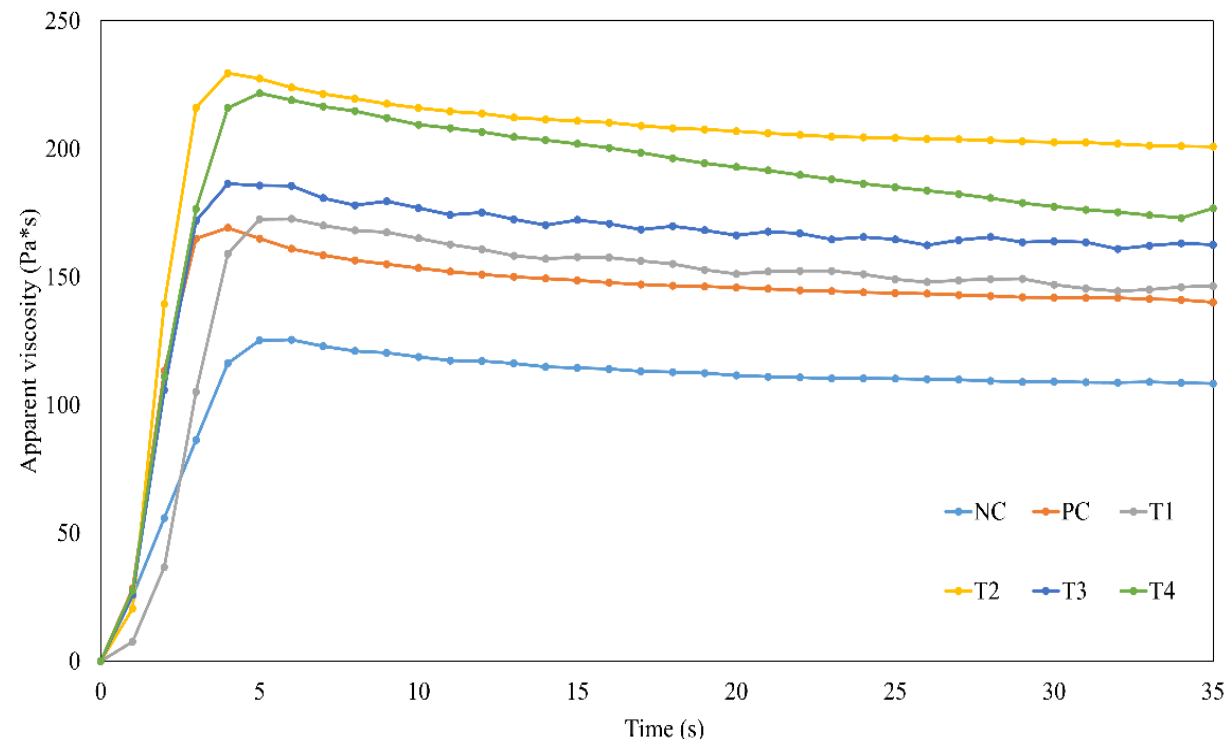
Figure 2. Effects of grafted insect protein and eggshell powder on the texture profile analysis of phosphate-free meat emulsion. NC: negative control not containing phosphate, PC: positive control containing 0.15% phosphate, T1: meat emulsion containing 0.10% GI, T2: meat emulsion containing 0.1% GI and 0.1% ES, T3: meat emulsion containing 0.15% GI, T4: meat emulsion containing 0.15% GI and 0.1% ES.